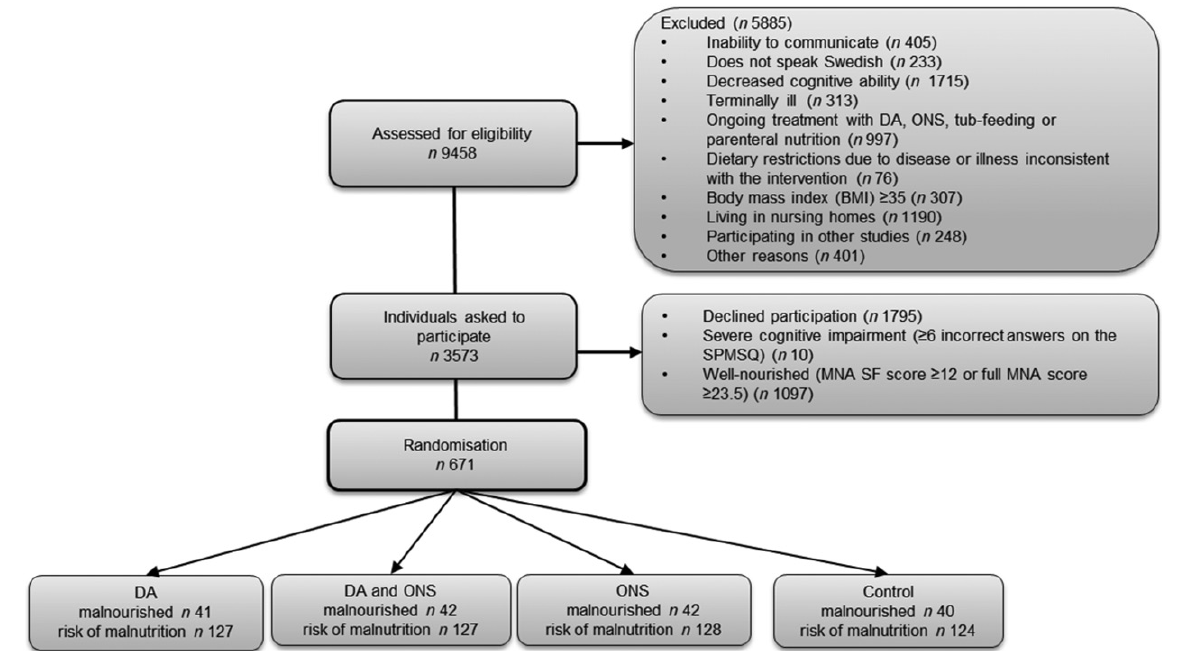
Figure 1. Flow chart describing the participant recruitment and randomisation process in five hospitals in central Sweden. DA: dietary advice; MNA: Mini Nutritional Assessment; MNA SF: MNA Short Form; ONS: oral nutritional supplements; SPMSQ: Short Portable Mental Status